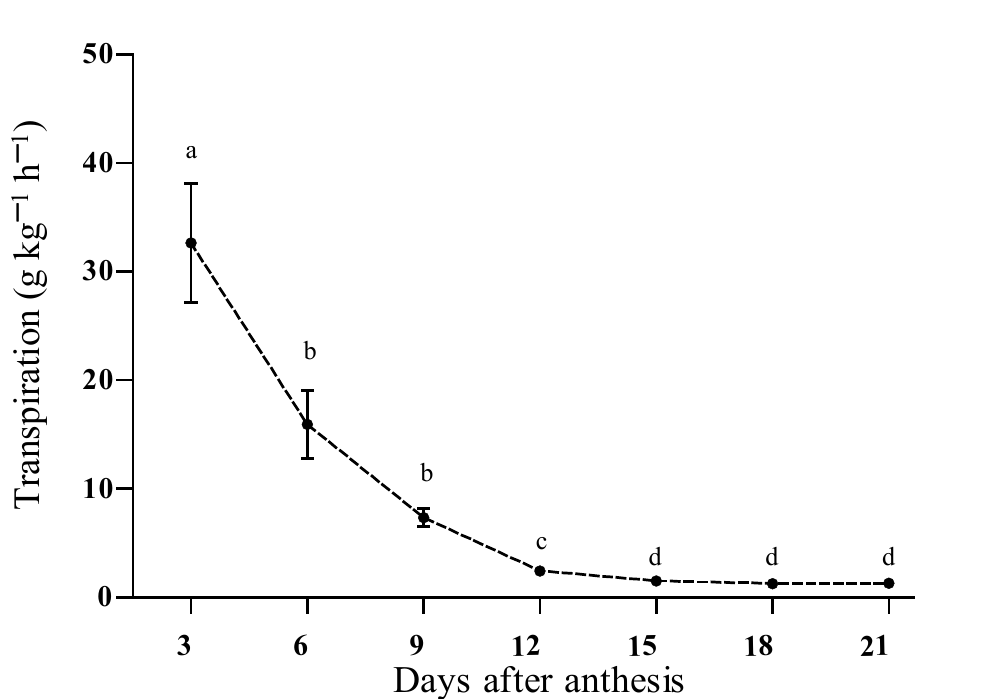
Figure 5. Transpiration in chayote fruits Sechium edule var. virens levis during development ( n = 3 ± standard deviation). Different letters show significant differences (Tukey test, α = 0.05).